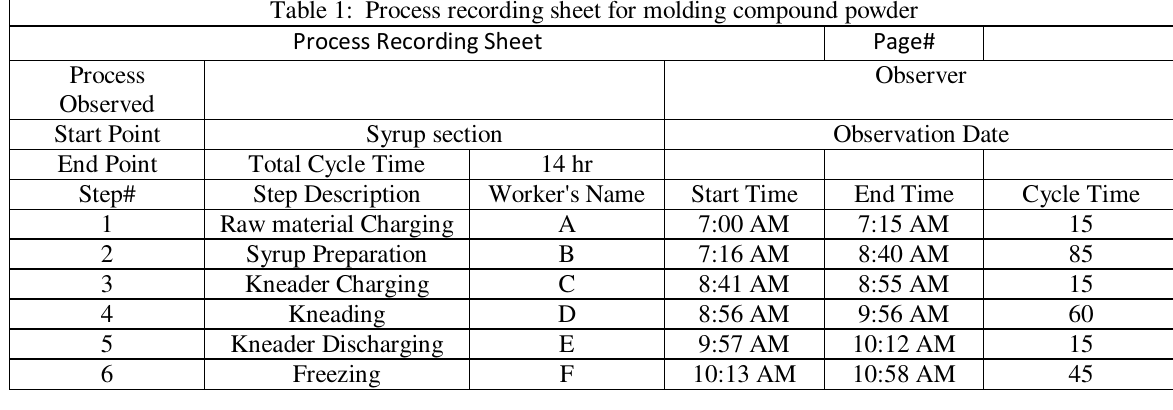
Table 1: Process recording sheet for molding compound